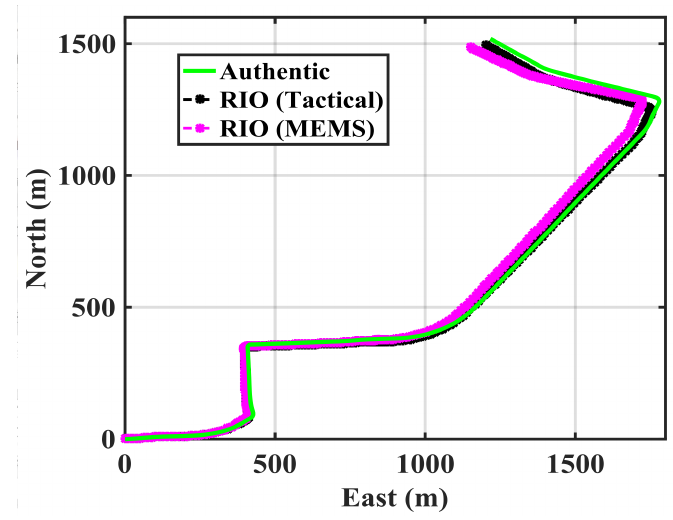
Figure 5. Standalone RIO mechanization for the two different IMUs used (350 s of data).